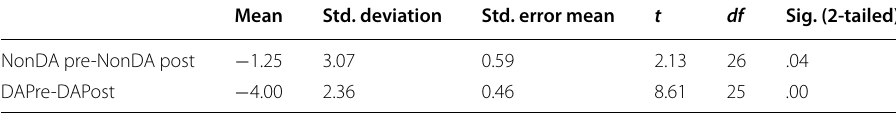
Table 10 Paired samples test (writing pre‑ and posttests of each group) Mean Std. deviation